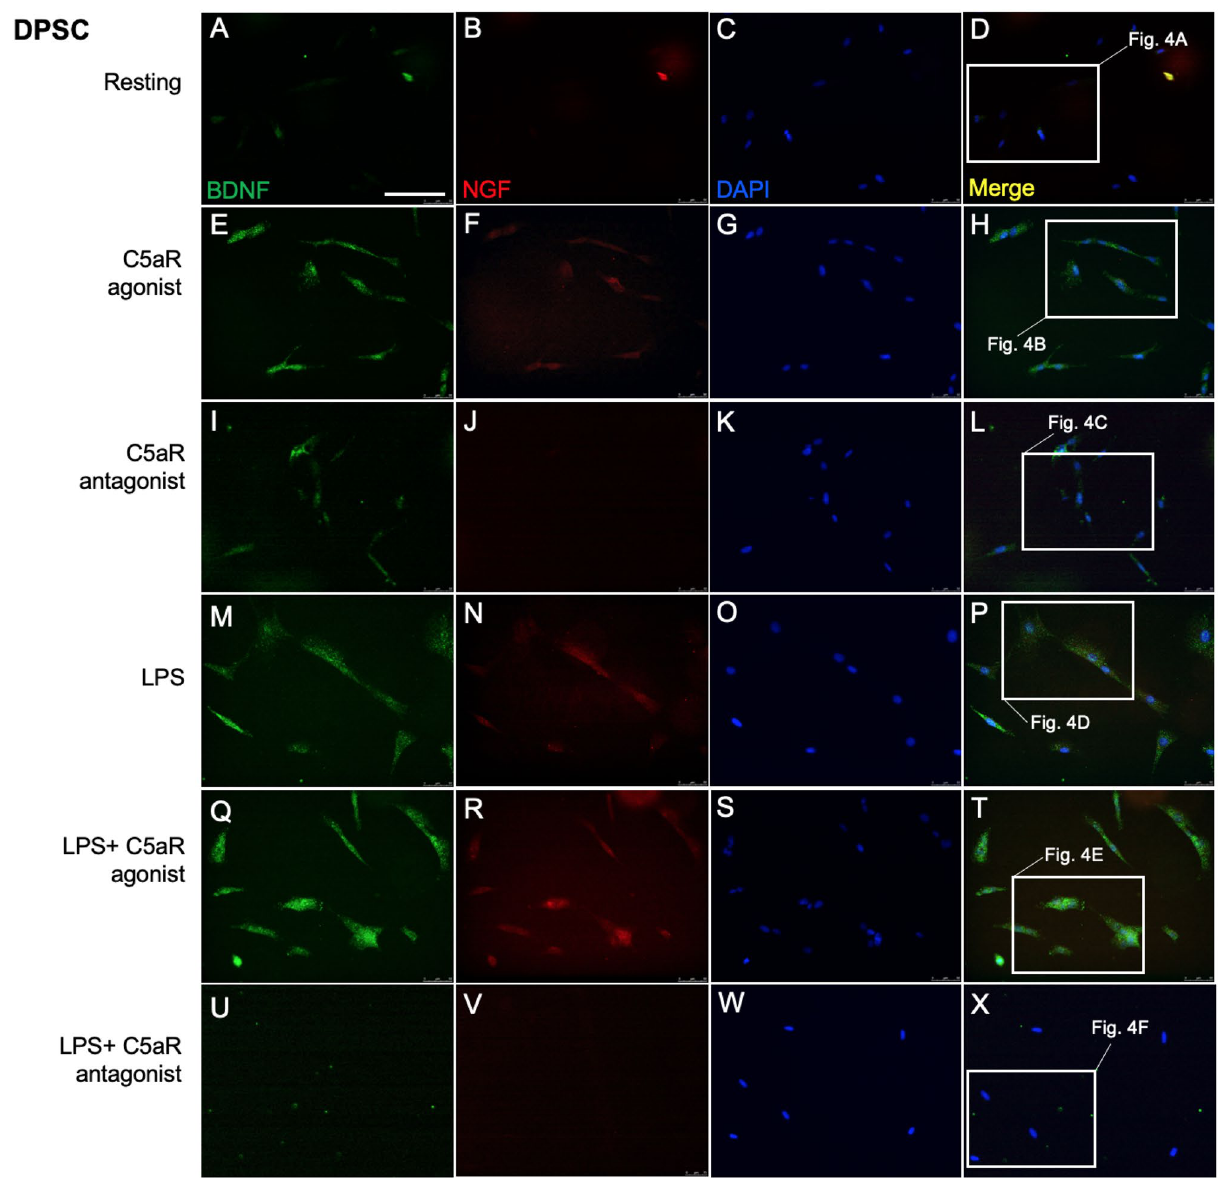
Figure 2. DPSCs express BDNF and NGF. Cultured cells were treated with C5aR-agonist or antagonist for 48 h and then stimulated with LPS for 1 h, and fixed and stained accordingly. Immunofluorescence double staining was used to analyze the expression of BDNF and NGF. Anti-BDNF (green) and anti-NGF (red) were found co-localized in the cytoplasm of DPSCs in C5aR-agonist treated cells after 48 h of treatment. Intense staining was observed in C5aR-agonist and LPS + C5aR-agonist treated cells. For each condition, negative controls, performed by replacement of the BDNF and NGF primary antibodies and secondary antibody used to detect BDNF was Alexa-488 (green) and NGF through Alexa-594 (red); nuclei were counterstained with DAPI (blue). Scale bar: 100